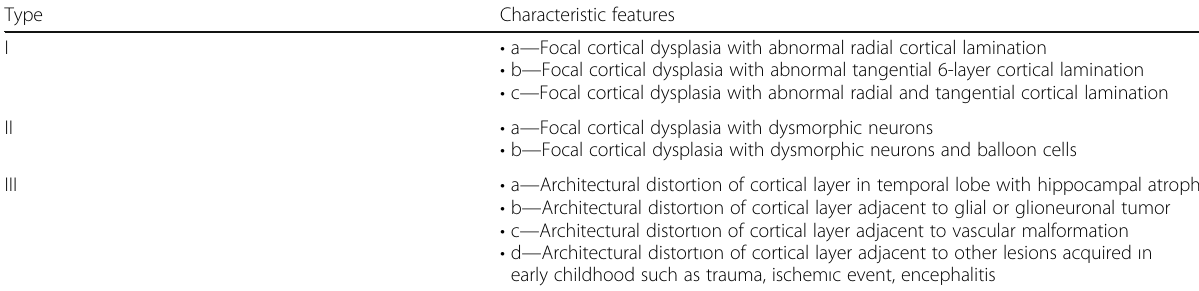
Table 1 New classification system of focal cortical dysplasia by Blumcke et al. 2011 Type Characteristic features